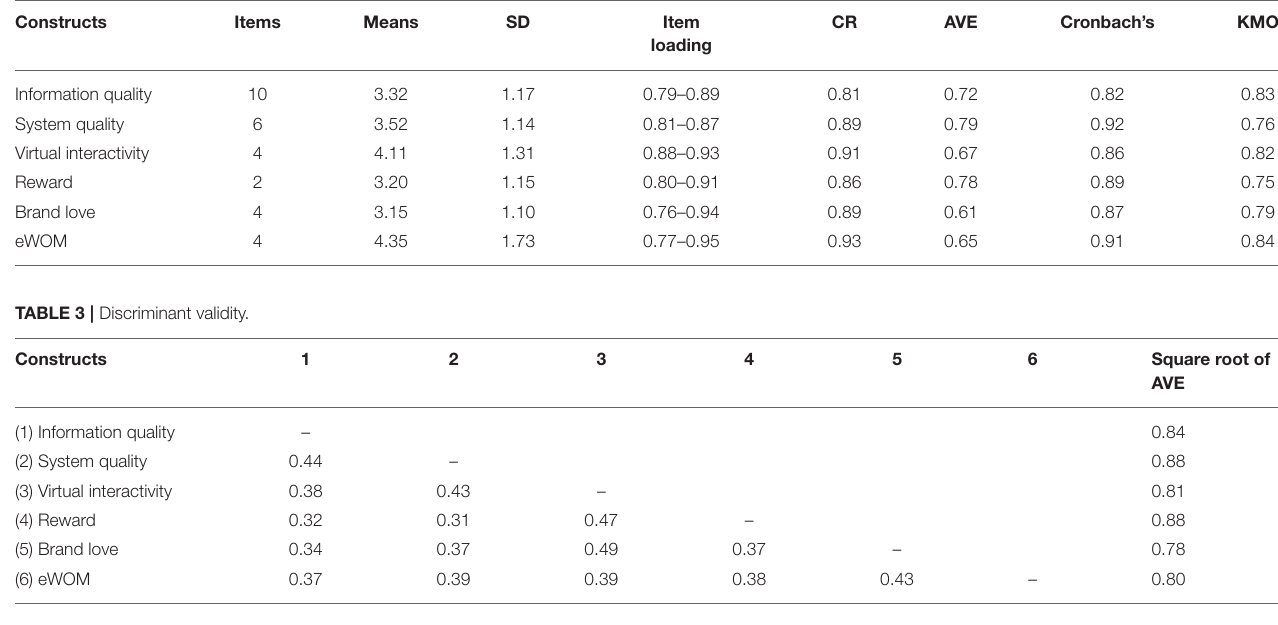
TABLE 2 | Reliability and convergent validity.